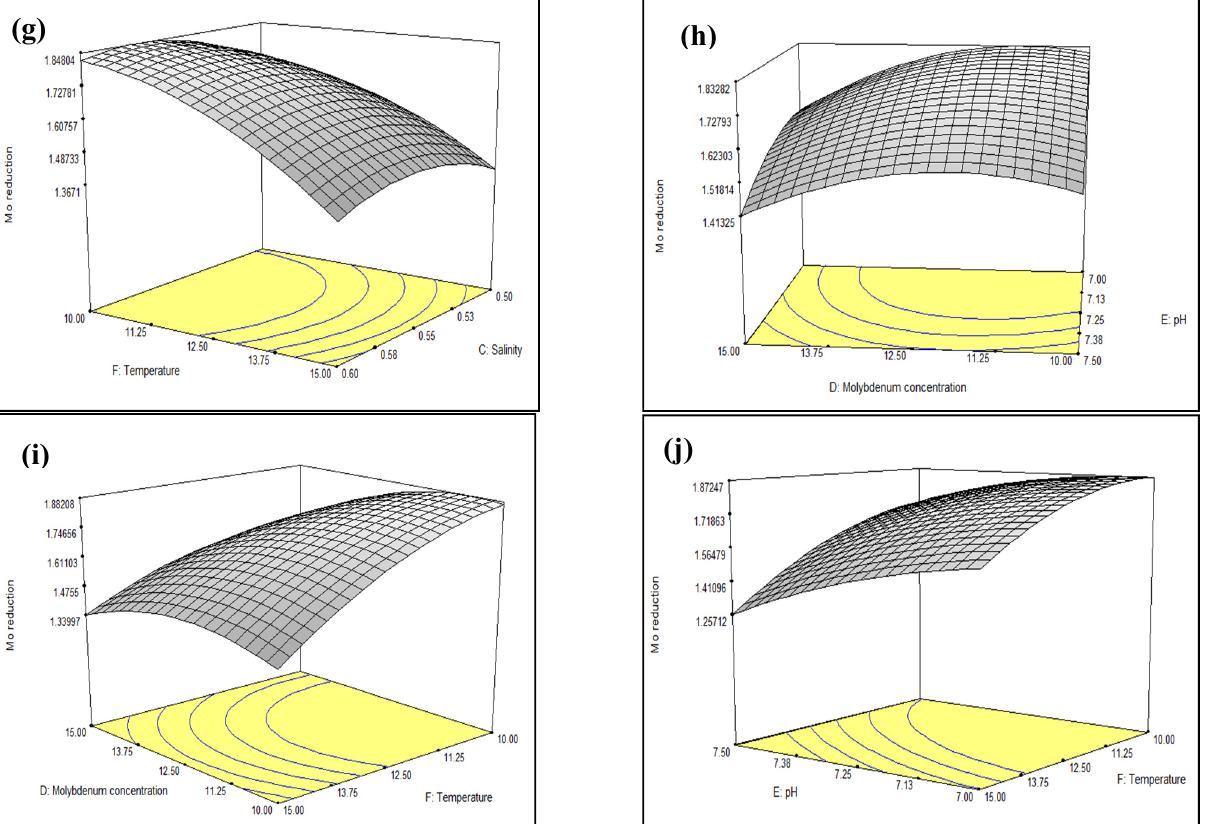
Figure 8. Three-dimensional contour plot showing the effect of interactions between a pair of parameters on Mo reduction by strain AQ5-05. ( a ) AB; ( b ) AD; ( c ) AF; ( d ) BC; ( e ) BF; ( f ) CD; ( g ) CF; ( h ) DE; ( i ) DF; ( j ) EF.